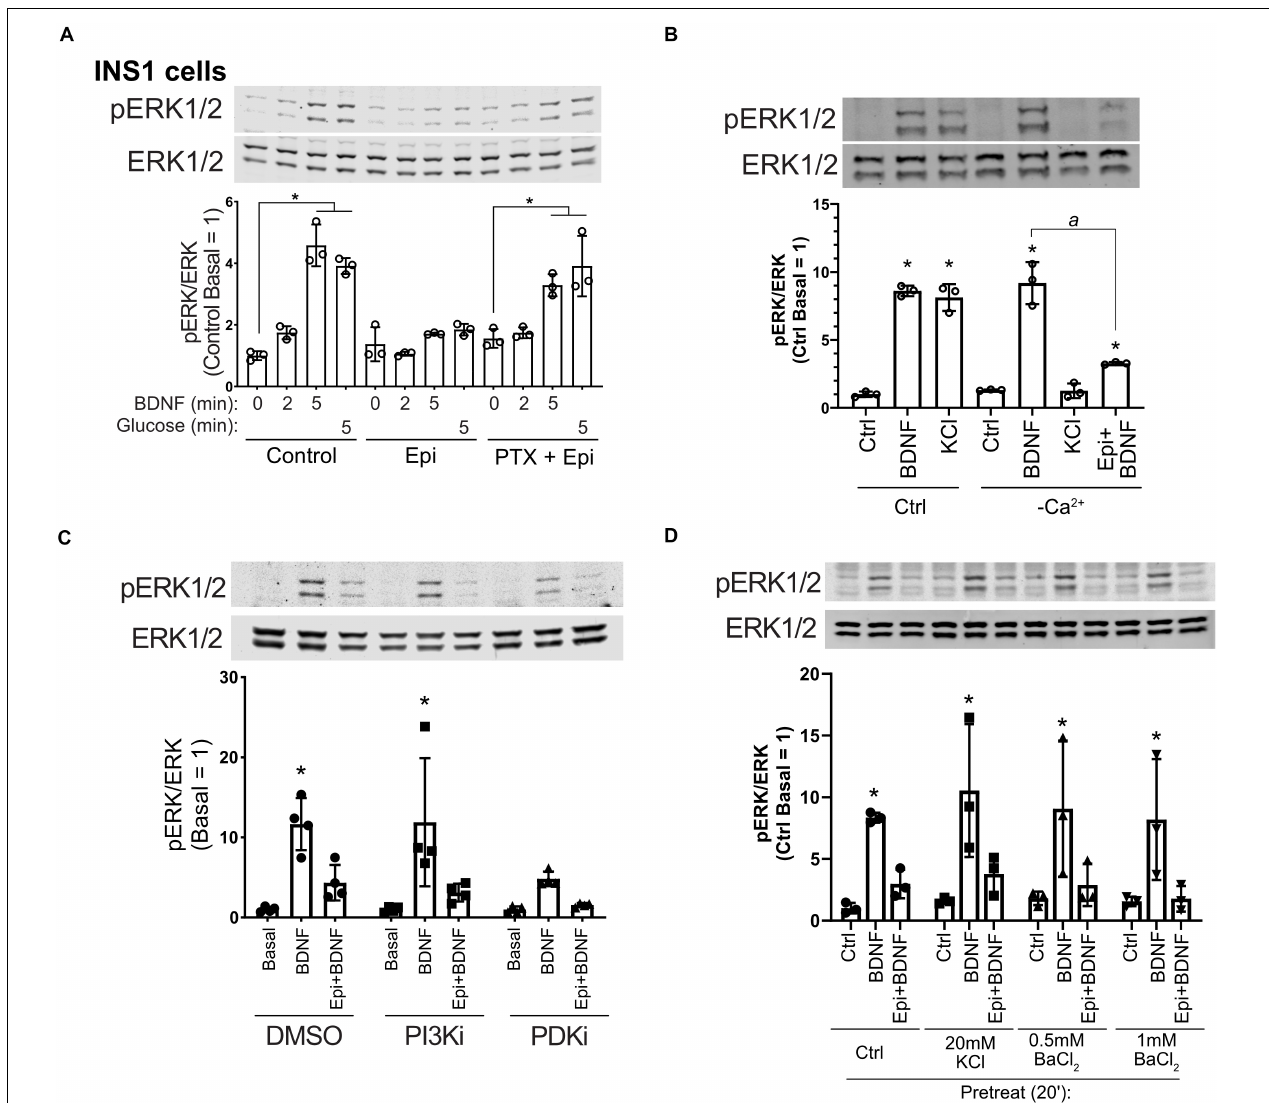
FIGURE 4 | Epinephrine blockade of BDNF signaling depends on G α i / o but is unaffected by Ca 2 + influx, PI3K/PDK1 inhibition, or treatment with KCl or BaCl 2 . (A) To determine the dependence of epinephrine on G i / o activation, INS1 β cells were treated with 200 ng/ml pertussis toxin (PTX) for 18 h in the culture medium. Cells were then incubated in KRBH with 2 mM glucose in the continued presence or absence of PTX for 2 h. Prior to stimulation, cells were treated with or without 10 µ M epinephrine for 15 min. Cells were stimulated with or without 10 ng/ml BDNF or 20 mM glucose for the indicated time. Data are the mean ± SD of three independent experiments. * P < 0.05 vs respective basal by two-way ANOVA using Dunnett’s multiple-comparison test. (B) To determine the requirement of Ca 2 + influx for BDNF-TrkB signaling, MIN6 cells were preincubated in normal (Ca 2 + -containing) or Ca 2 + -free KRBH (compensated with additional 2 mM MgCl 2 ) without glucose for 2 h. 15 min prior to stimulation, 10 µ M epinephrine was added where indicated. Cells were stimulated with 10 ng/ml BDNF or 50 mM KCl for 5 min. Data are the mean ± SD. * P < 0.05 compared to respective basal; a, P < 0.05 by one-way ANOVA using Tukey’s multiple-comparison test. (C) To determine if PI3K/PDK1 inhibition prevents the effects of epinephrine on BDNF signaling, MIN6 cells were preincubated for 1.5 h in glucose-free KRBH and then treated with DMSO (0.1%), GDC-0941 (250 nM), or GSK2334470 (250 nM) for 15 min. Cells were then treated or not with 5 µ M epinephrine for 15 min before stimulation with BDNF (10 ng/ml) for 5 min. Bar graph represents the mean ± SE for four independent experiments. * P < 0.05 vs. Basal by two-way ANOVA with Dunnett’s multiple-comparison test. (D) To block potassium channels potentially involved in membrane hyperpolarization, MIN6 cells were preincubated in glucose-free KRBH for 1 h and 40 min at which point KCl or BaCl 2 were added. At 1 h and 45 min, epinephrine (5 µ M) was added. At 2 h cells were stimulated with BDNF for 5 min and then harvested for Western blot analysis. All data are the mean ± SD of N = 3 experiments. * P < 0.05 by two-way ANOVA using Dunnett’s multiple comparisons test.